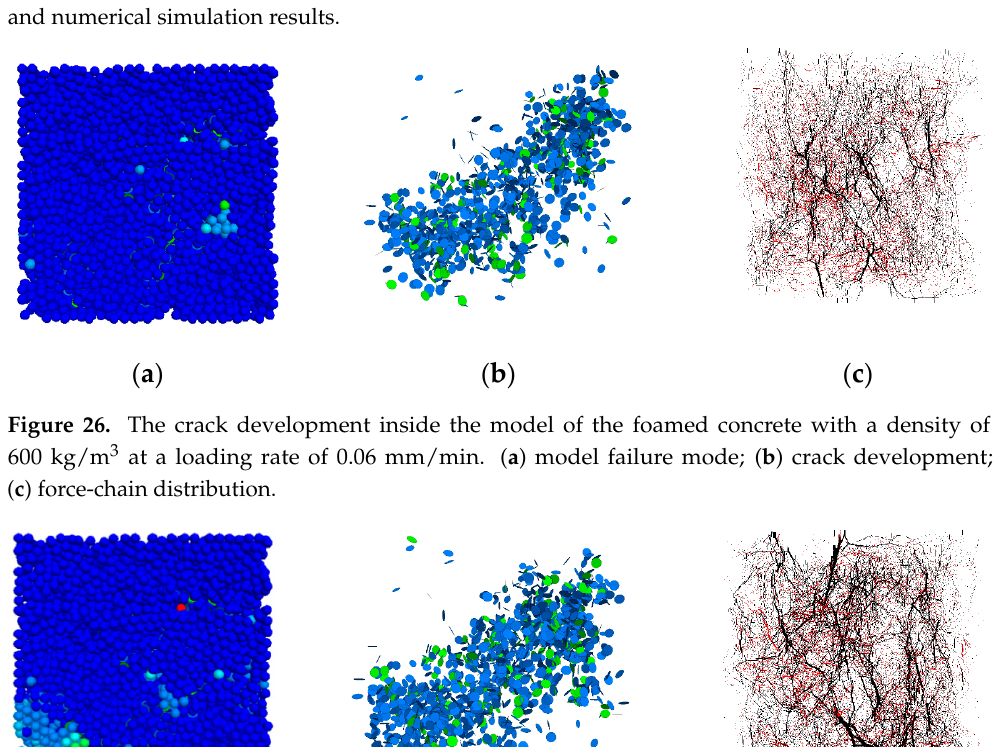
Figure 25. Relationship between compressive strength and loading rate of foam concrete of the test and numerical simulation results.